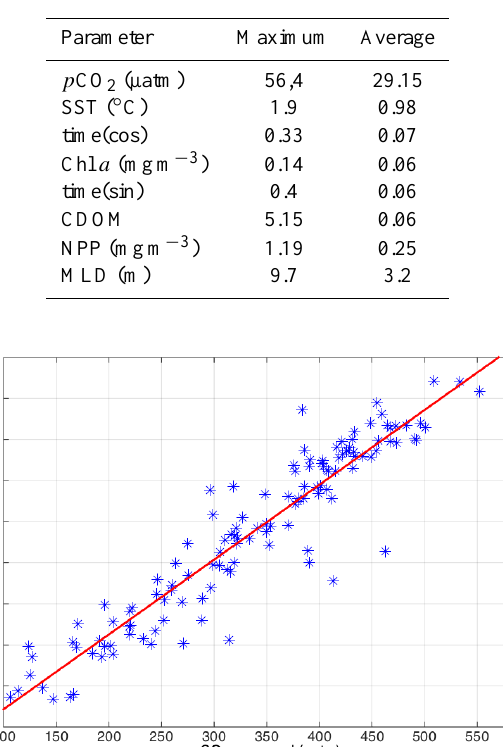
Table 3. Maximum and mean value observed in the difference be- tween the data used for the trainee and the value in the neurons.